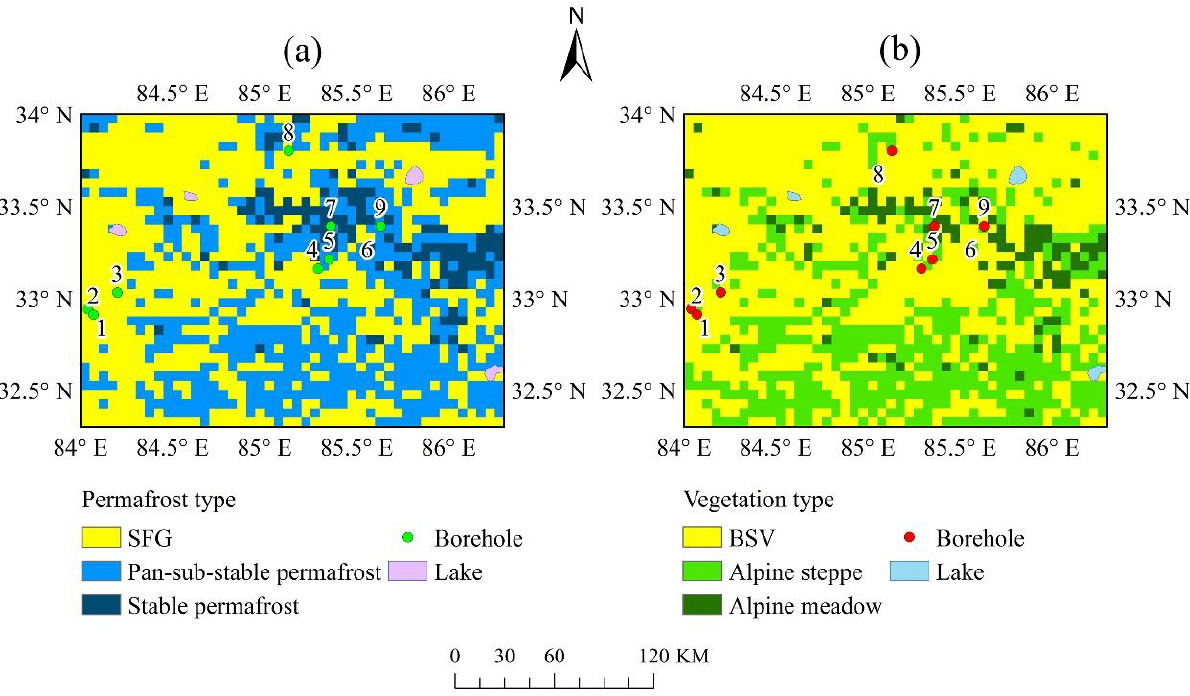
Figure 11. Distribution of ( a ) permafrost types and ( b ) vegetation types in the Gaize area (Borehole number 1 to 9 correspond to the borehole ID in Table